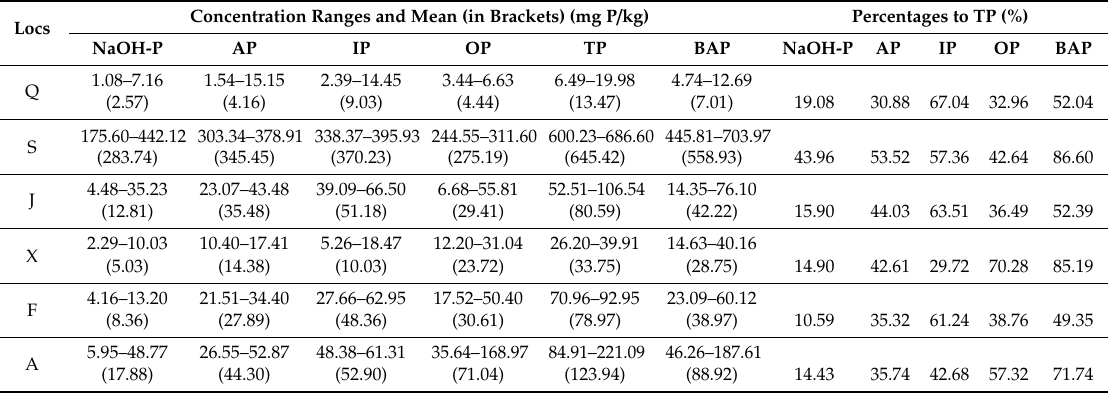
Table 1. Ranges, mean and percentages P